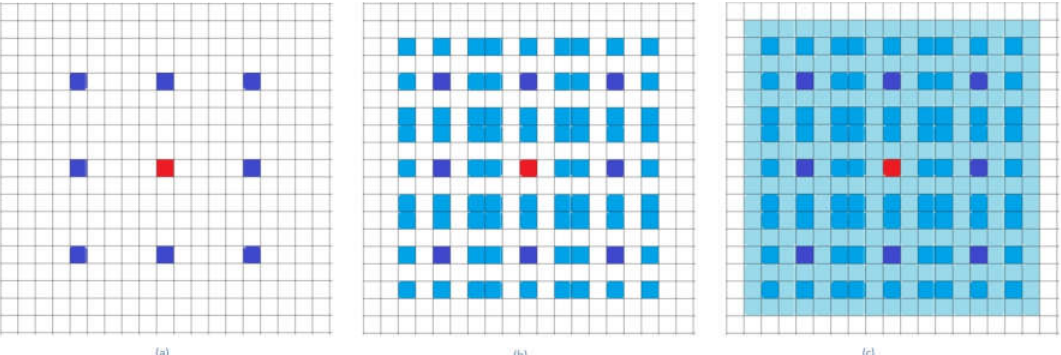
Figure 2. The receptive field of the last level of the atrous convolution group: ( a ) Receptive fields of the last level of the group, the atrous convolution module rated 5. ( b ) Receptive fields of the group’s last two level atrous convolution modules rated 2 and 5. ( c ) Receptive field of the group’s first, second and third level modules combined.